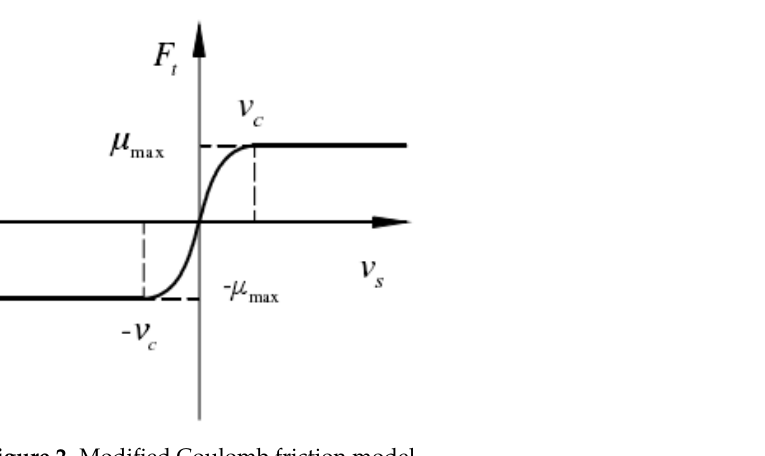
Figure 2. Modified Coulomb friction model.